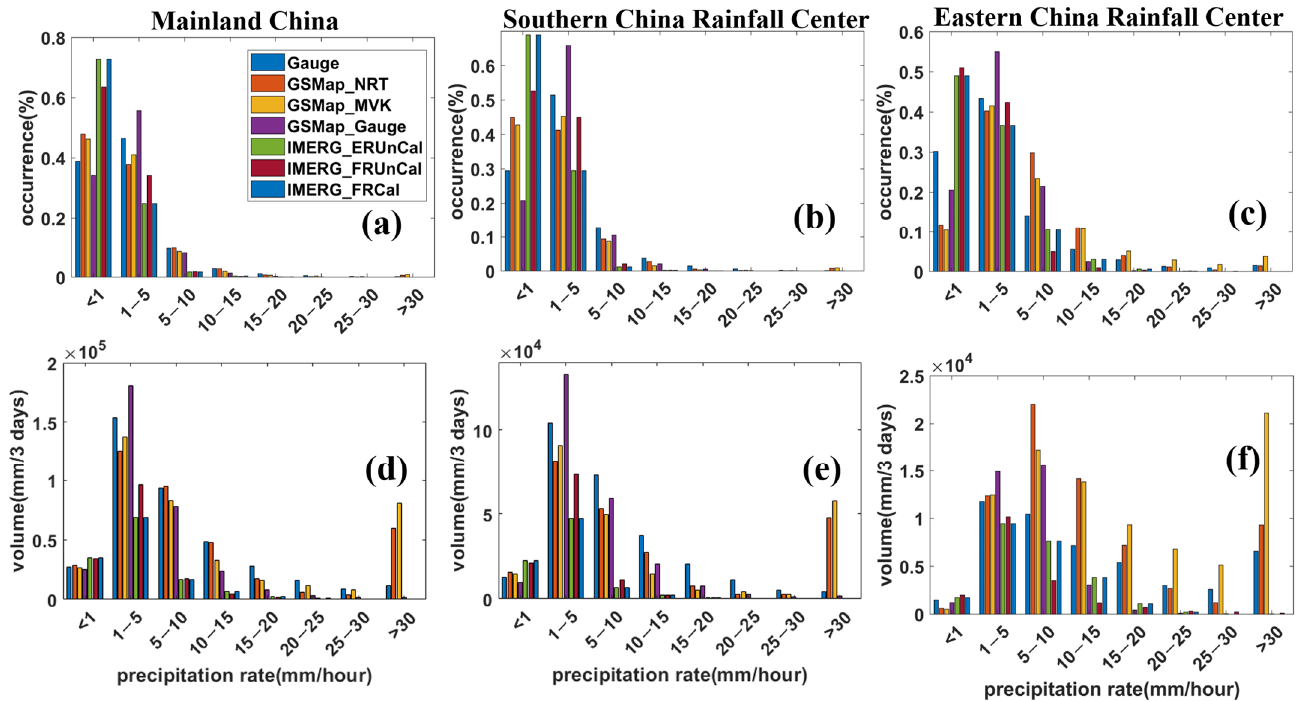
Figure 6. Probability distribution function by ( a – c ) occurrence (PDFc) and ( d – f ) volume (PDFv) of hourly precipitation for different intensities over mainland China and two rainfall centers.